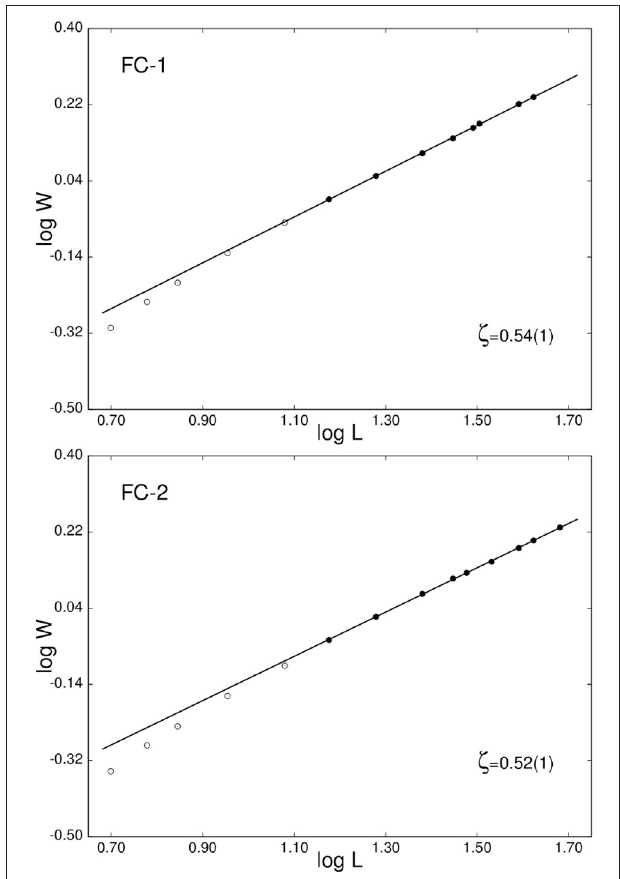
FIGURE 9 | Log-log plots for average roughness, W , as a function of system size, L , for a large number of fractured samples. Disorder magnitude is D = 1.5. Shown at the top (FC-1) is the result obtained with the “maximum normal stress” criterion, Equation (84). Shown below (FC-2) is the result obtained with the “maximum shear stress” criterion, Equation (77). Black dots indicate those values to which the straight line has been fit using linear regression.